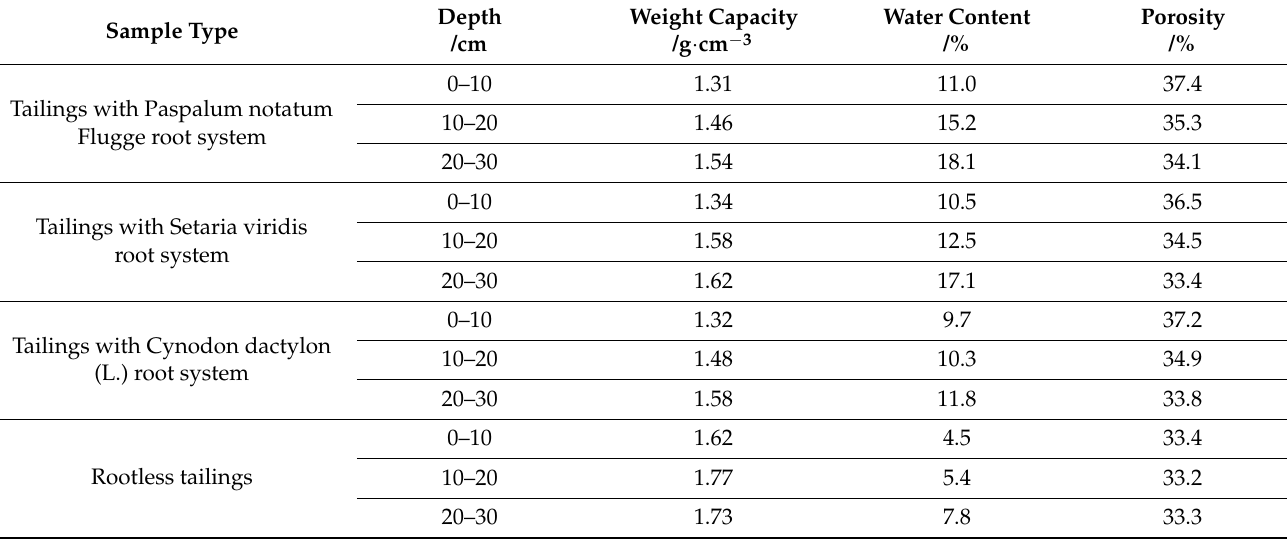
Table 3. Basic physical properties of rare earth